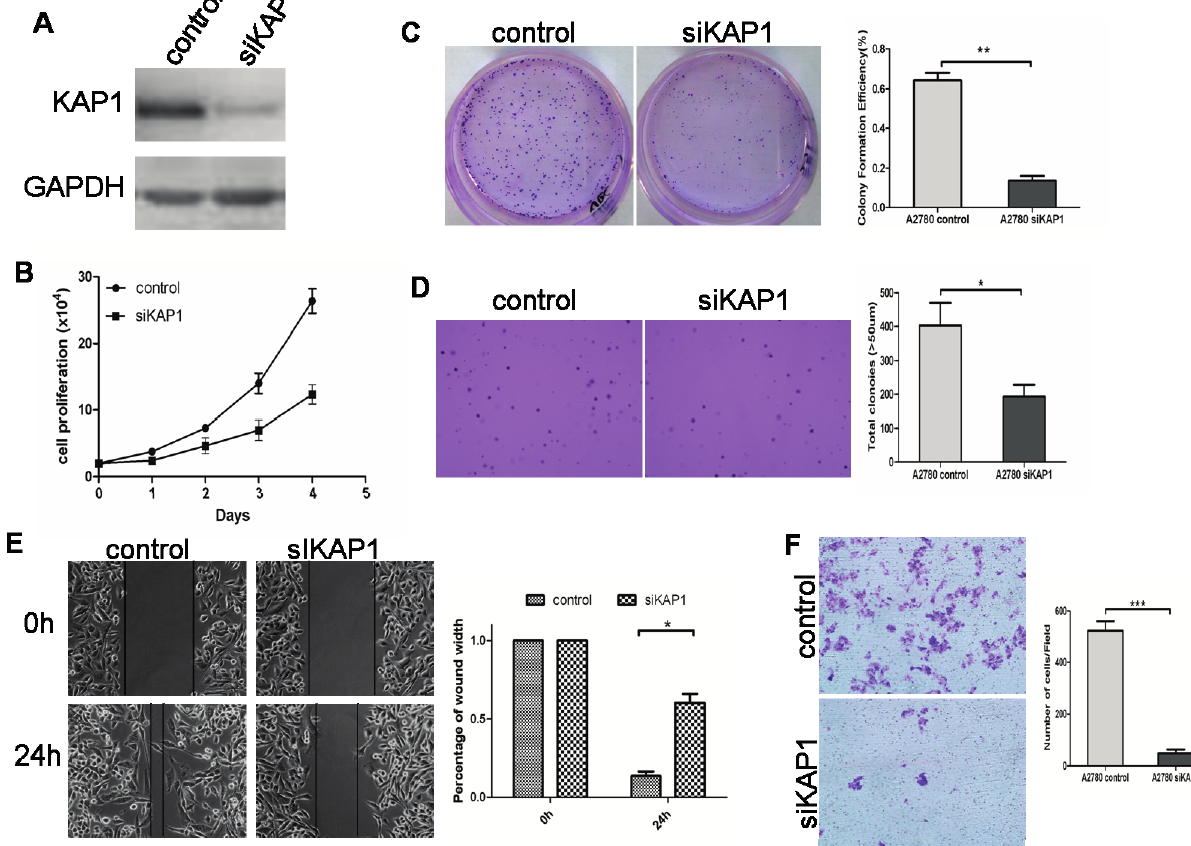
Figure 6. Downregulated expression of KAP1 inhibits cell growth and migration in A2780 cells. ( A ) western blot indicates the KAP1 interference efficiency; ( B ) MTT assay at 0, 24, 48, 72 and 96 h after transfection; ( C ) representative images of two-dimensional culture of cells; ( D ) representative images of soft agar colony formation assay of cells (100×); ( E ) photographs represent cells migrated into the wounded area, and histogram shows the relative migration distance of cells in the wound-healing assay (200×) and ( F ) transwell migration assay (100×). ( * p < 0.05; ** p < 0.01; *** p <